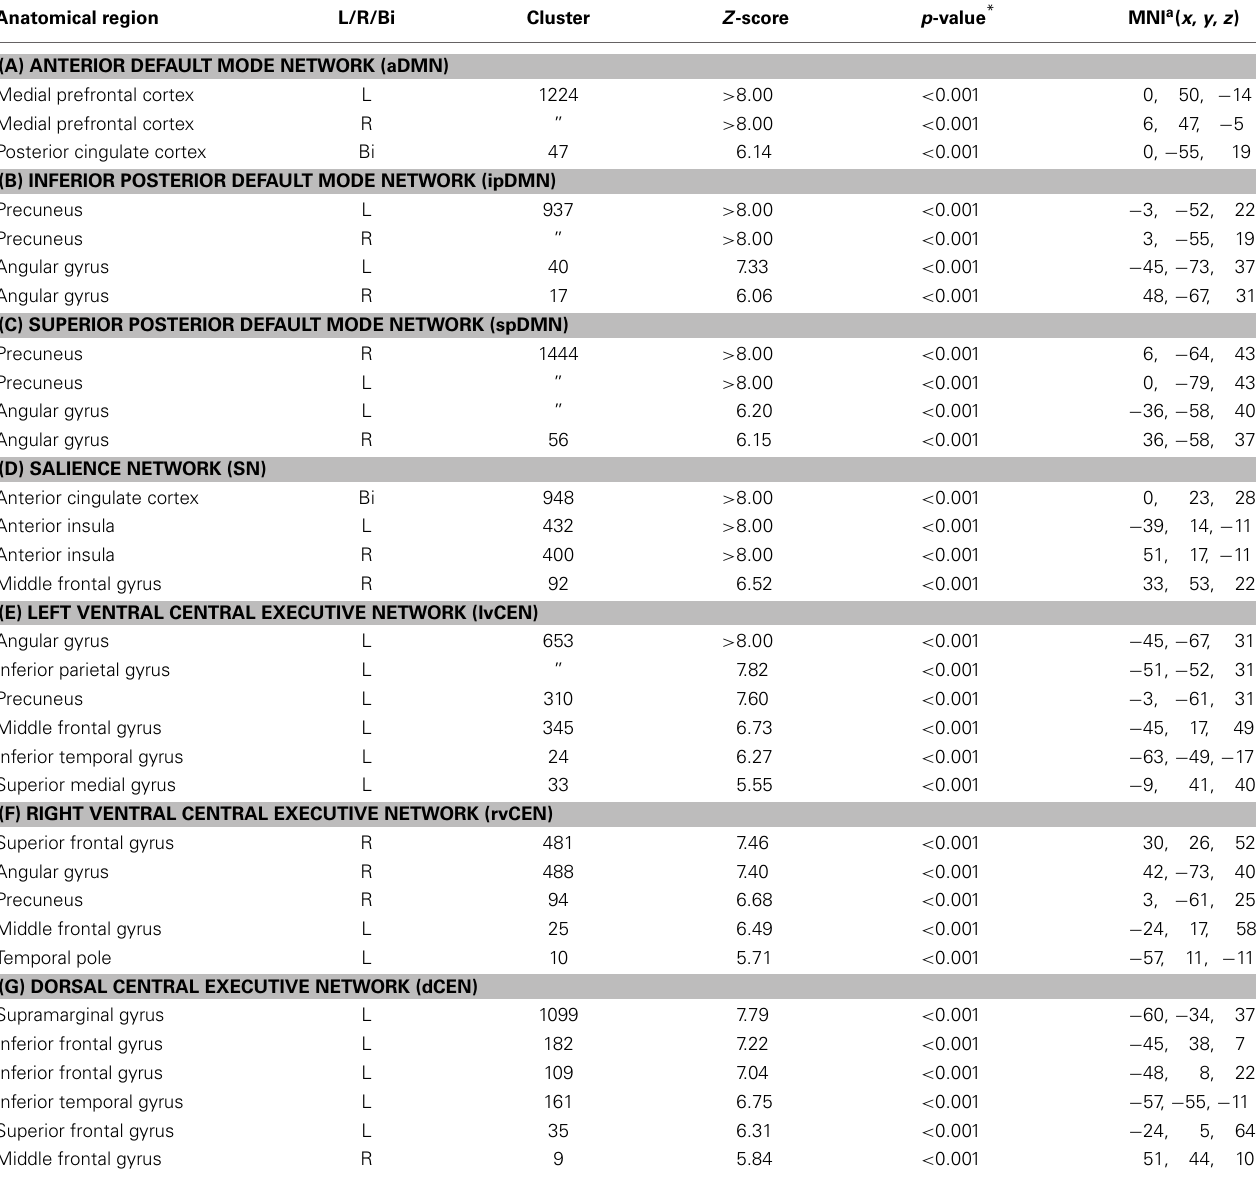
Table 2 | Intrinsic connectivity networks in healthy controls.